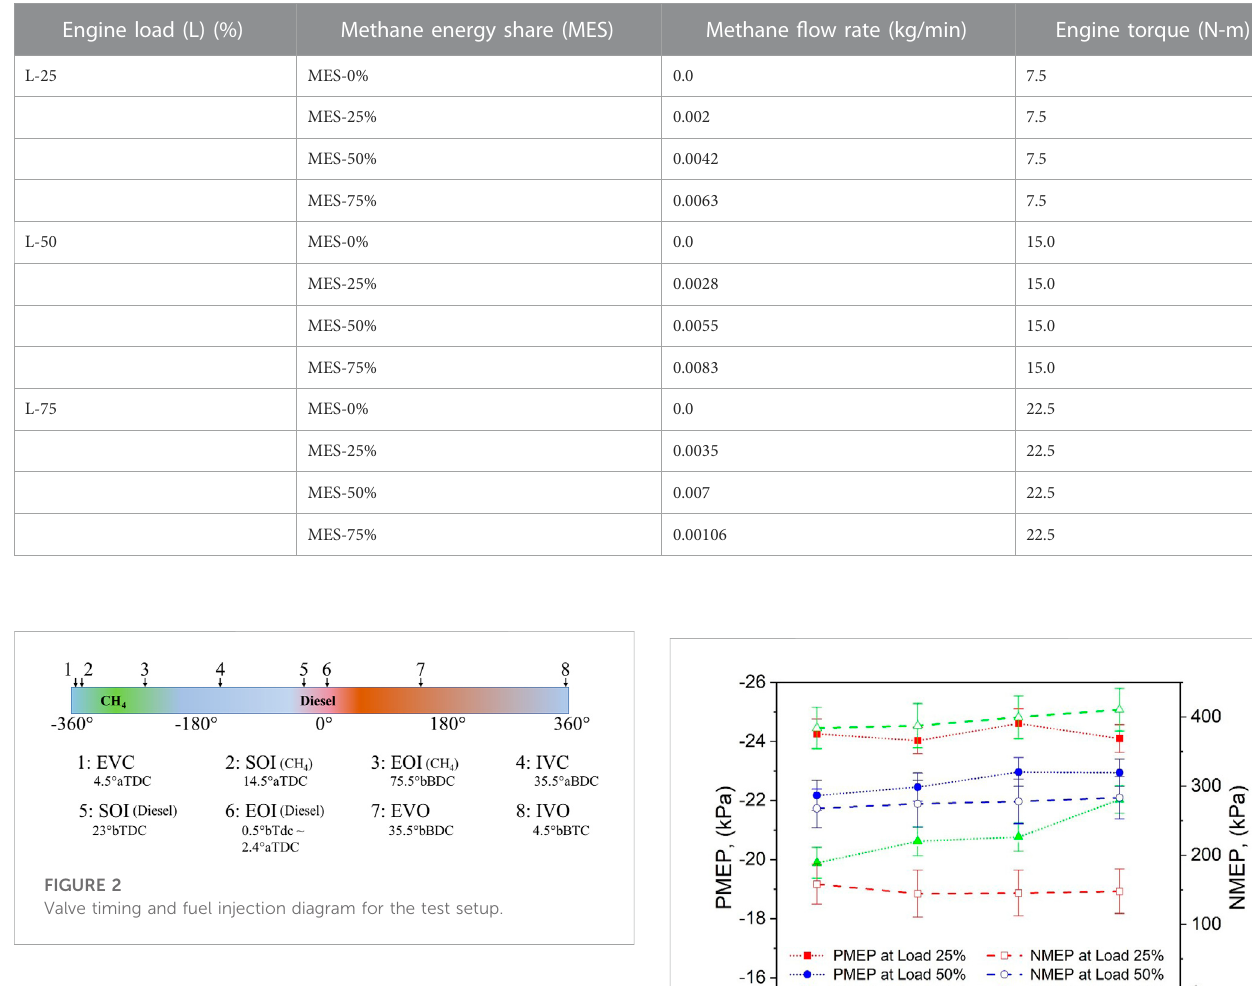
TABLE 3 Test Matrix for different operations.